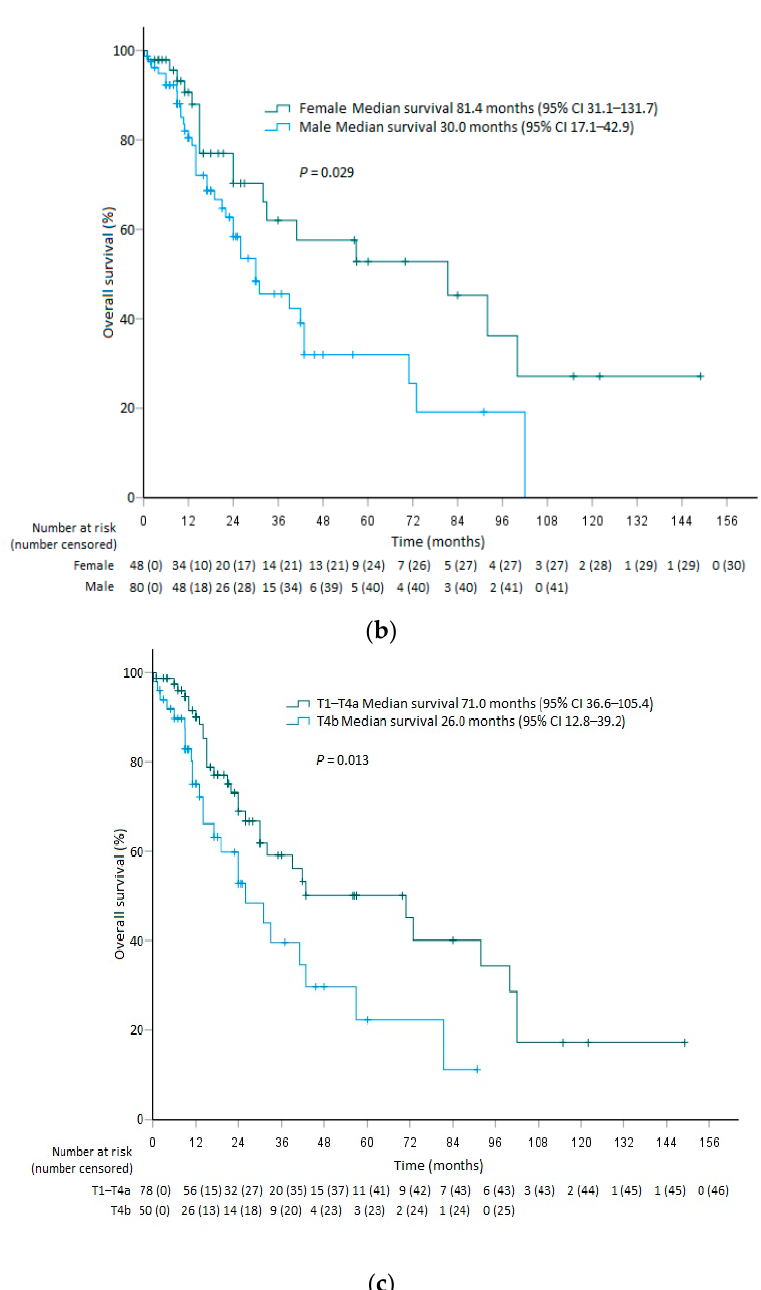
Figure 2. Kaplan–Meier estimates of overall survival showing ( a ) the whole study population ( n = 128), and the results stratified by ( b ) sex, and ( c ) T1 ‐ 4a vs. T4b disease.